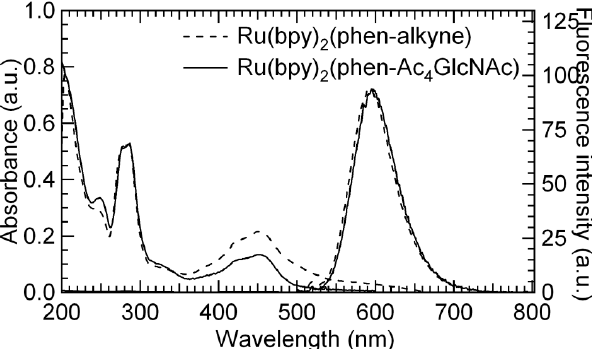
Figure 1. UV-vis absorption and fluorescence spectra of 4 and 5 in MeOH. λ ex = 450 nm.